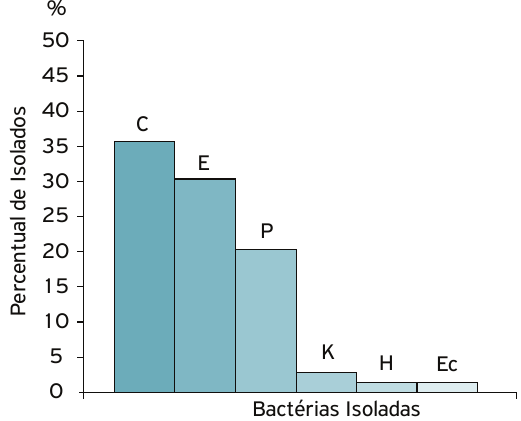
Figura 2. Isolamento de enterobactérias em amostras de fezes de